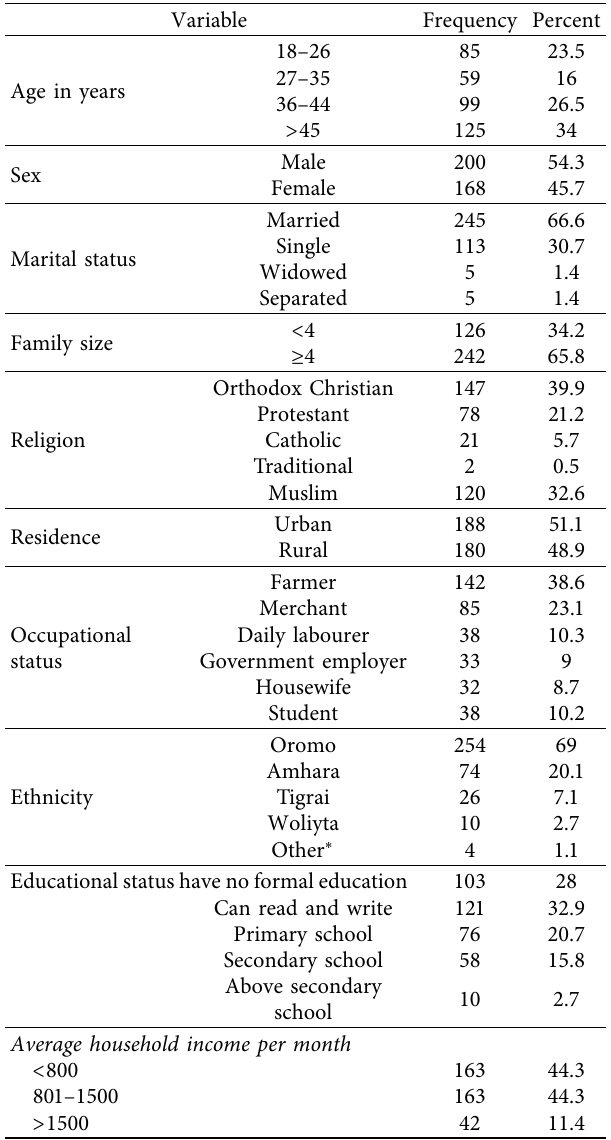
Table 1: Socioeconomic and demographic characteristics of TB patients in government health institutions of Shashemane, Ethiopia, 2017 ( n �